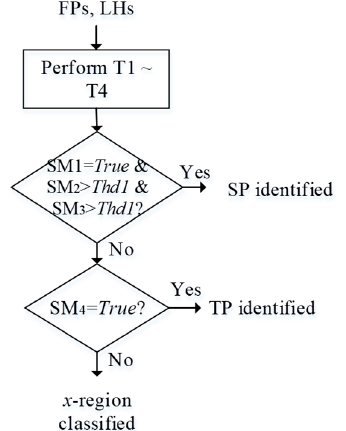
Figure 8. Test flow for the classification of a region s into SP , TP , or x -region.